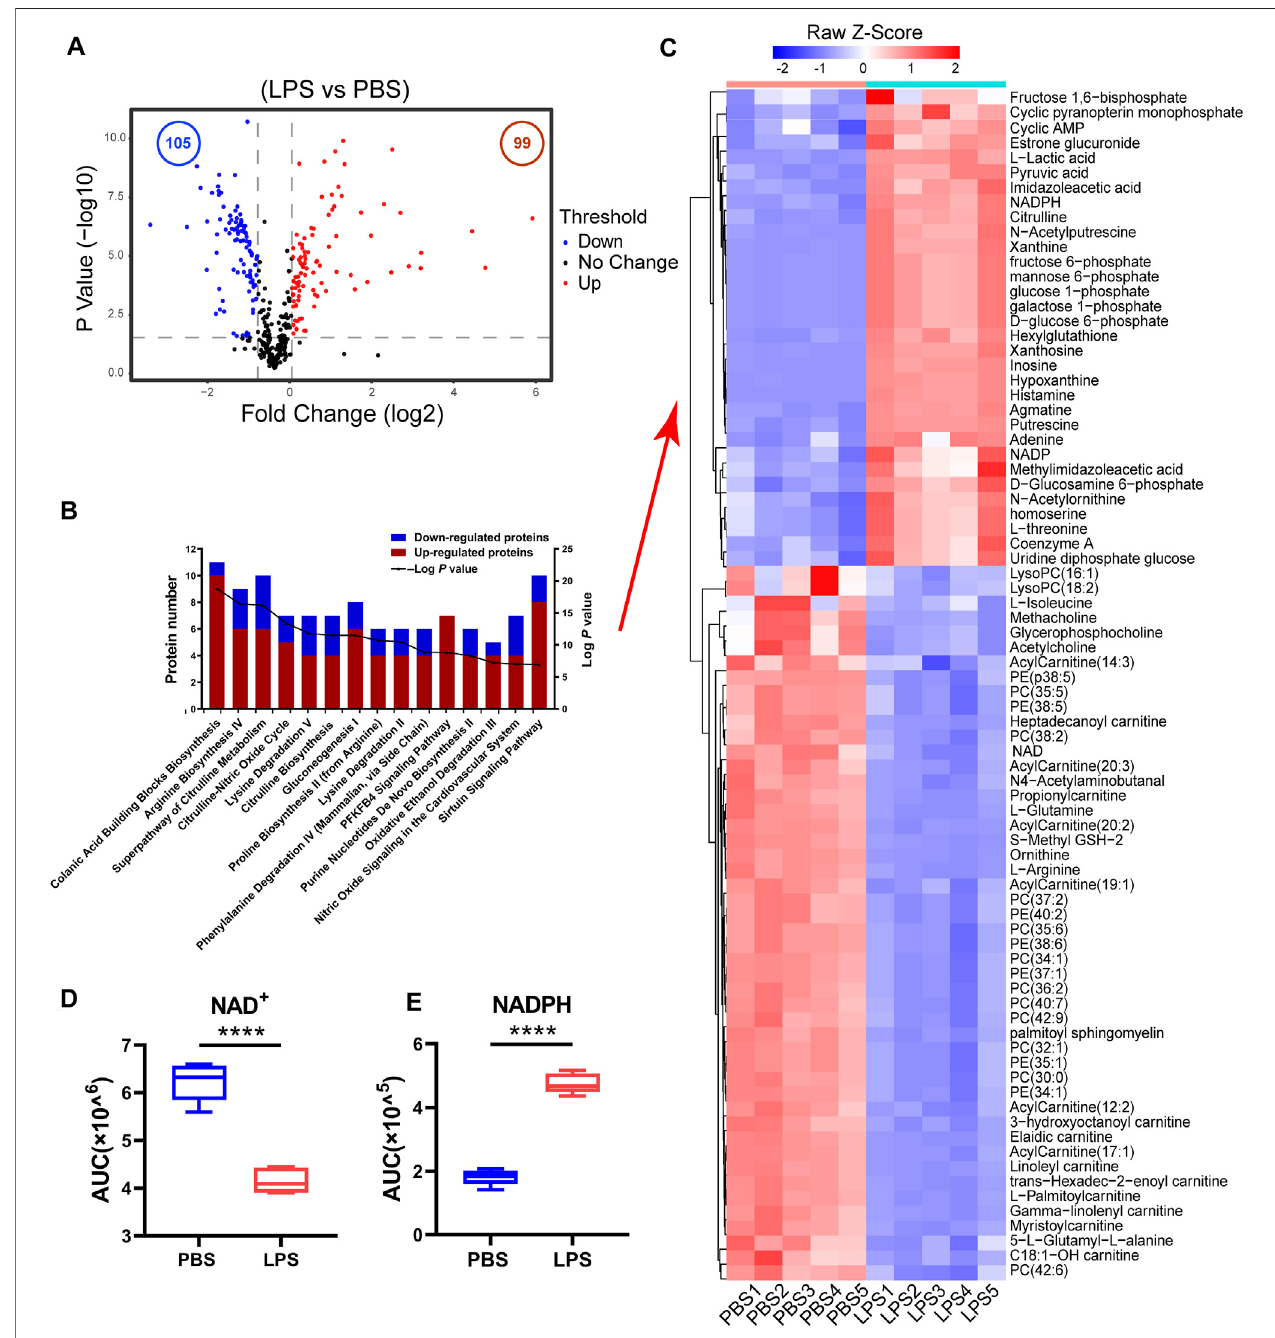
FIGURE 1 | The cellular NAD + content decreased in LPS-activated macrophages. (A) A volcano plot of metabolites in LPS-treated cells compared with control cells. Blue and red dots represent the decreased and increased metabolites ( p -values < 0.05, ratios ≤ 0.75 or ≥ 1.33), respectively. (B) Functional enrichment analysis of the changed metabolites. The red bar represented the number of increased metabolites while the blue represented the number of decreased ones in different biological processes(LPS-treatedcellsversusuntreatedcells > 1.33-foldor < 0.75, p < 0.05). (C) Heatmapclusteringanalysisofthechangedmetabolitesselectedbasedon IPAanalysisinLPS-treatedcellascomparedtothoseinuntreatedcells. (D,E) NAD + andNADPHlevelsfromthemetabolomicsdata(**** p < 0.0001,** p < 0.01,* p < 0.05, n (cid:2) 5, mean ± SEM).